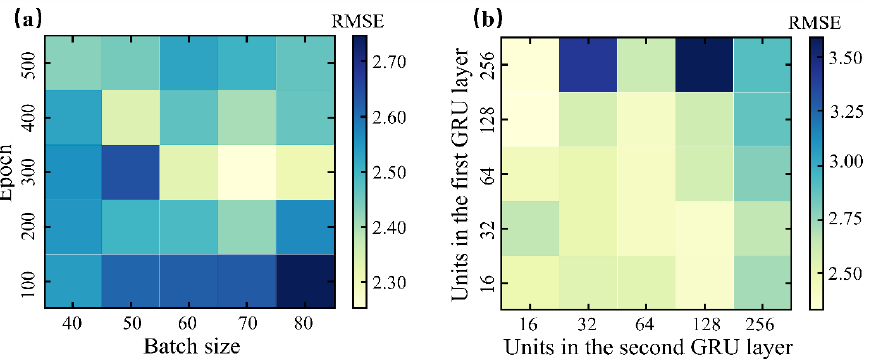
Figure 2. The parametric heatmap for ( a ) batch size and epoch, and ( b ) the numbers of units in the first layer and the second layer of the Gated Recurrent Unit (GRU) models.